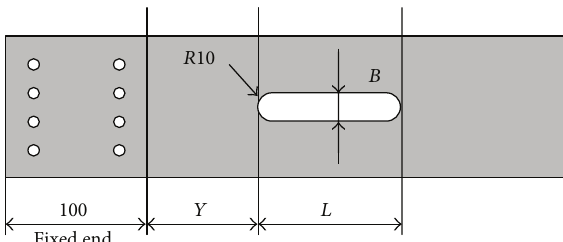
Figure 4: The definition of defects of test sample of this study.